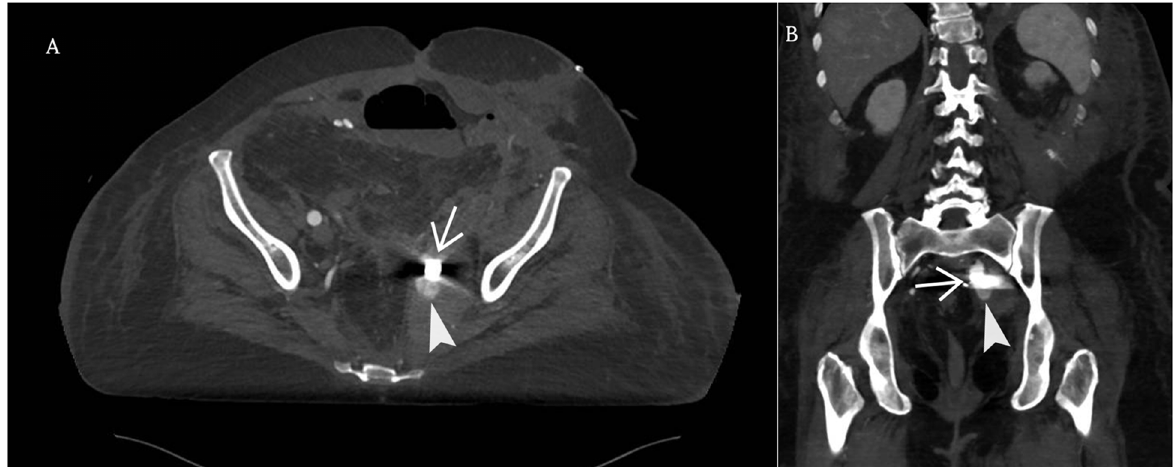
Fig. 3 CT angiogram of the left internal iliac artery 7 days after embolization of mycotic pseudoaneurysm with onyx A ) Axial and B) MPR coronal CT angiogram demonstrates enlarged left internal iliac artery mycotic pseudoaneurysm sac measuring 8 (arrowhead) and prior